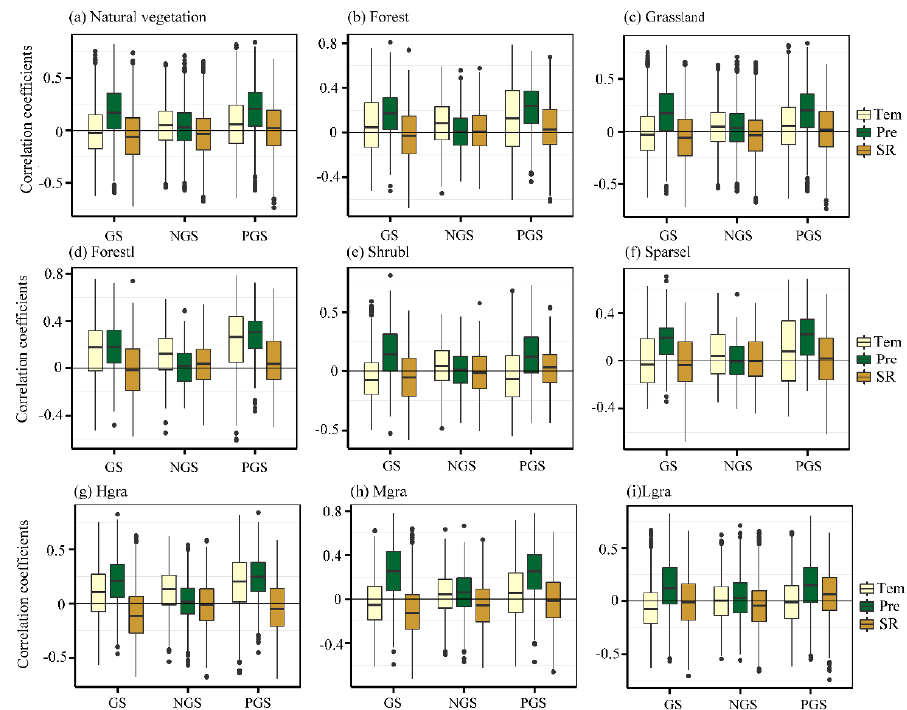
Figure 6. Box plots of grid correlation coefficients between detrend Normalized Difference Vegetation Index (NDVI) and detrend climate variables in the arid region of northwestern China (GS: growing season; NGS: non-growing season; PGS: Partial correlation in growing season).